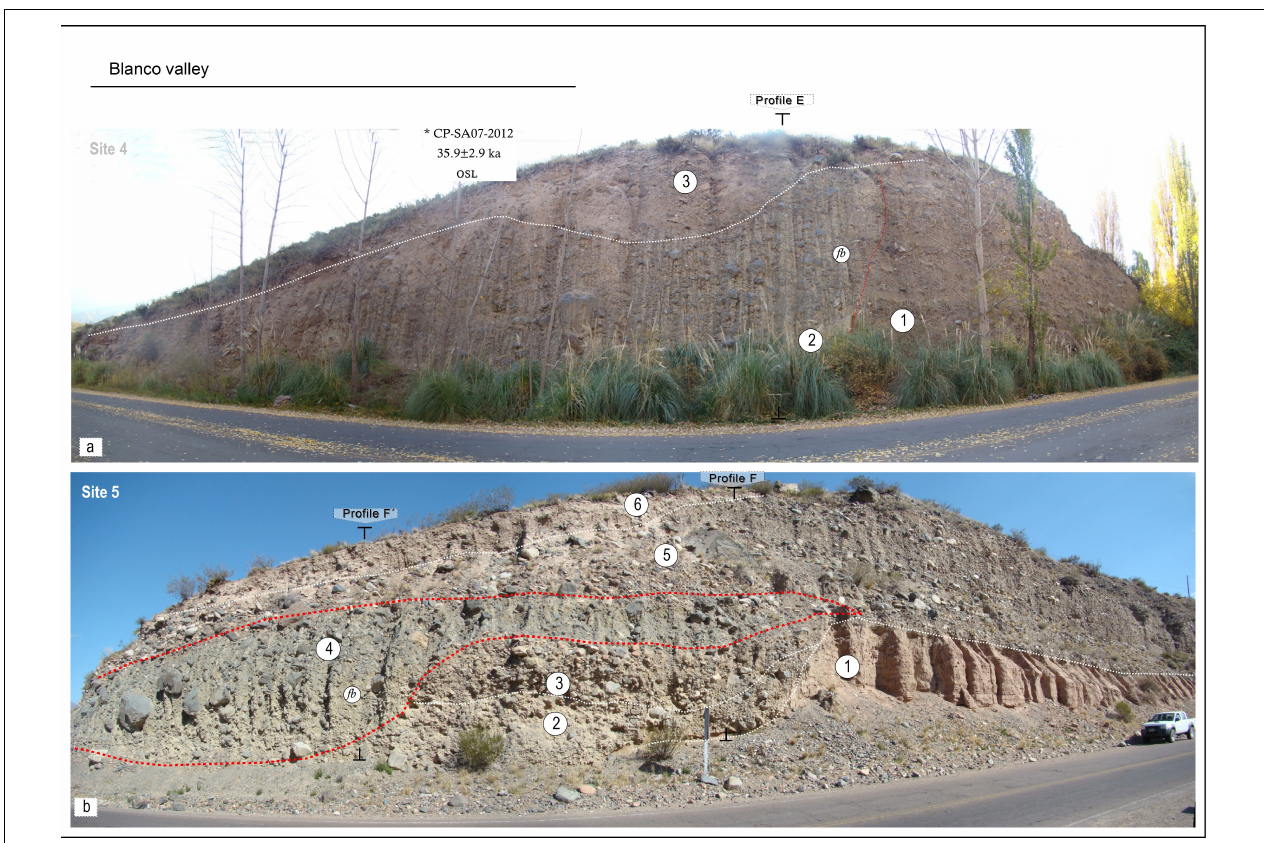
FIGURE 6 | Cross sections along the Blanco River where the Plata rock avalanche outcrops: (a) Cross section at site 4 where unit 1 corresponds to gravel alluvial deposits, 2. the Plata rock avalanche with apparent vertical lamination due to vertical erosion ( fb is facie b), and 3. finer alluvial deposits where the sample CP-SA07.12 was taken for OSL dating. (b) Cross section in site 5 where unit 1 corresponds to Tertian outcroppings, 2. and 3. paleo-channel deposits, 4. the rock avalanche, 5. outwash deposit, and 6. alluvial deposits. See profiles on Figure 7 .